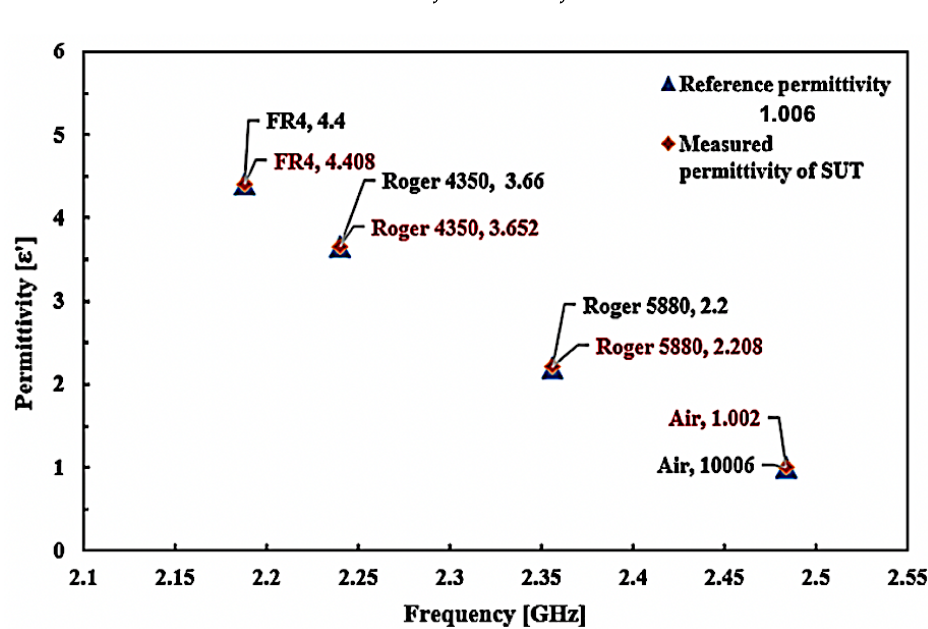
Figure 17. Comparison of the ideal and measured real part permittivity of various solid SUTs.